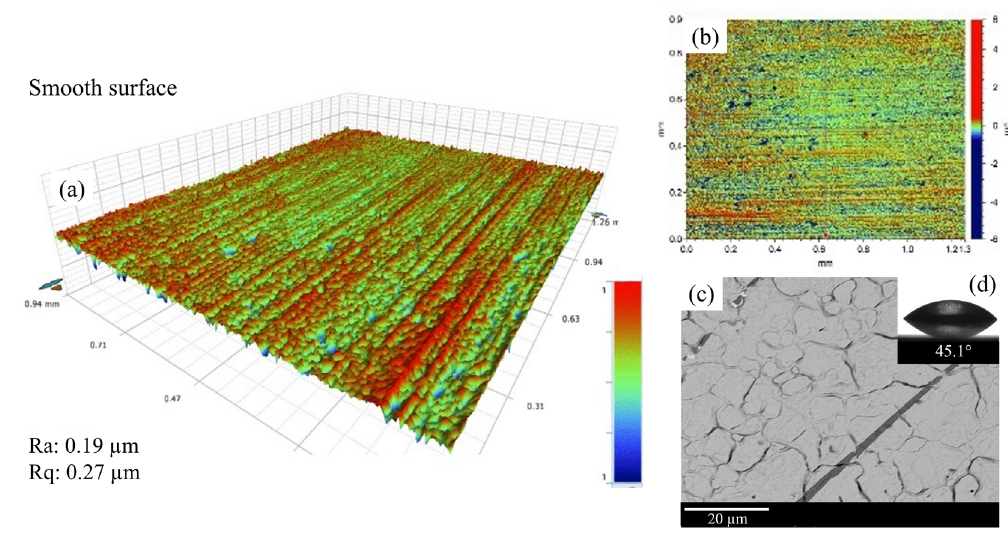
Figure 1. Optical profiling in 3D (a) and 2D (b), top-view SEM image (c), and a contact angle (d) of the smooth stainless-steel substrate